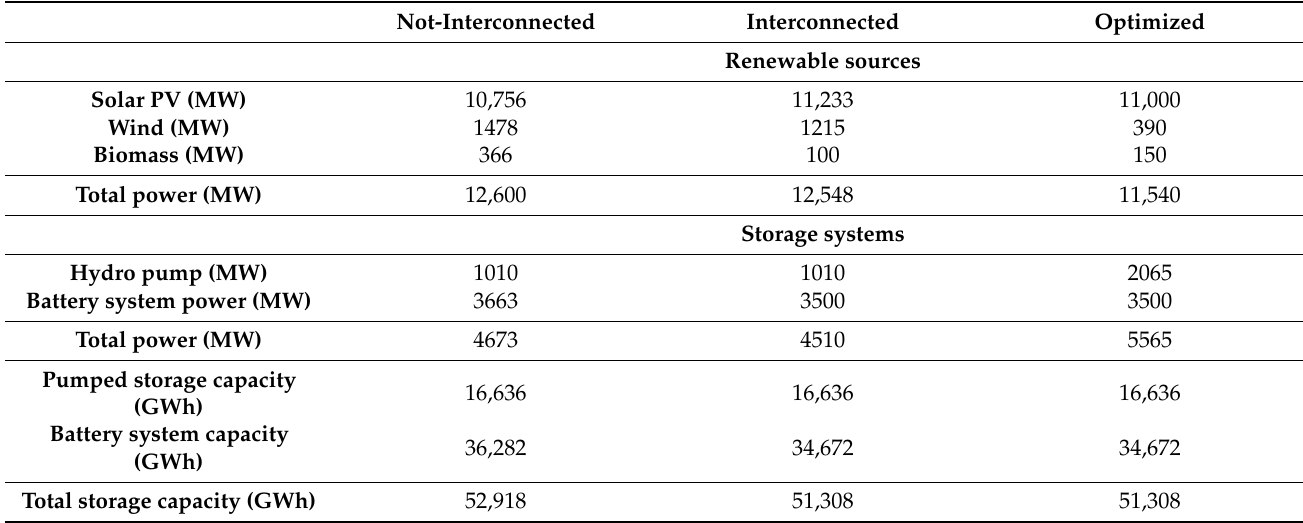
Table 9. Comparison of the installed generation and storage powers and the storage capacity between the three scenarios analyzed.